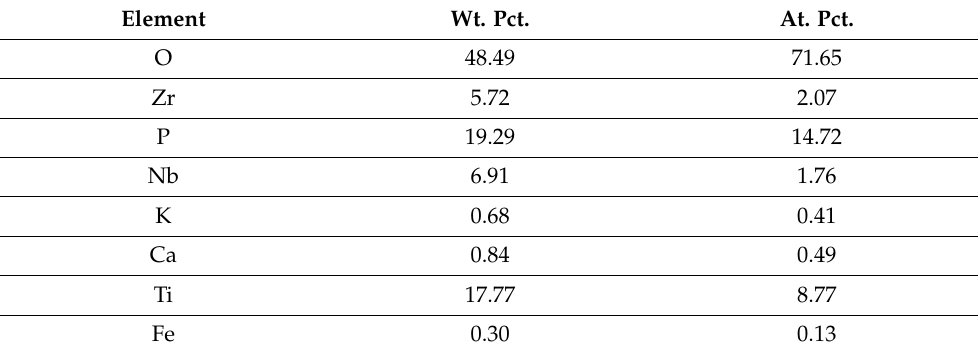
Table 2. The EDS examination results of the chemical composition of the oxide layer. Element Wt. Pct. At.